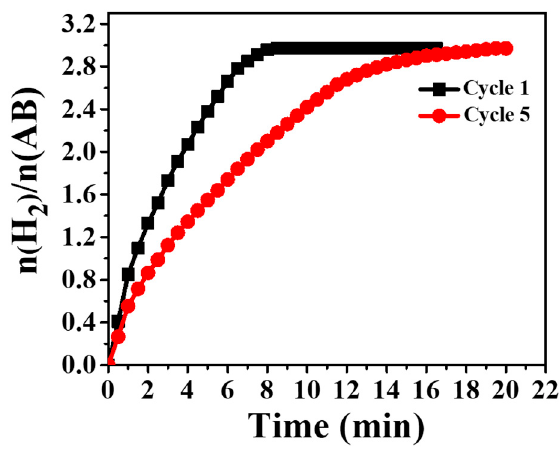
Figure 9. The catalytic performance of Cr 2 Ni 3 NPs@CNFs (15 wt% CrAc at 25 °C) during recycling.